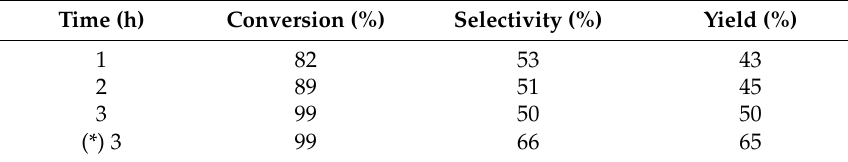
Table 2. Time profile of TiO 2 -SO 3 H performance on the fructose dehydration in water. Time (h) Conversion (%)